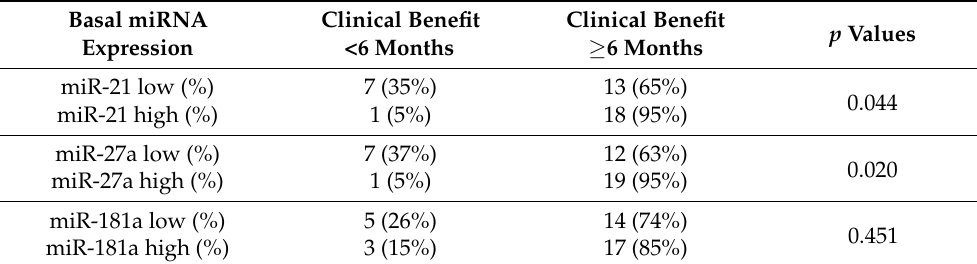
Table 2. Correlation between basal miRNA values and clinical benefit to EGFR-TKI.